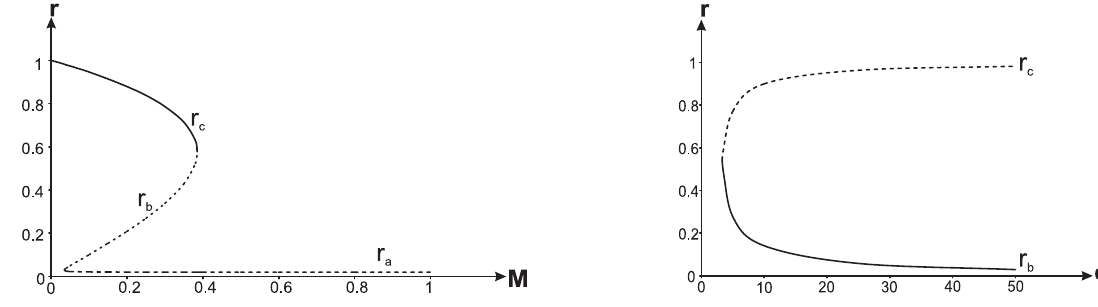
Figure 1. Horizons r a , r b and r c for q = 50 ( left ); double horizon r b = r a and cosmological horizon r c coinciding at the triple horizon ( right ) at q = q cr . Distances are normalized to r λ